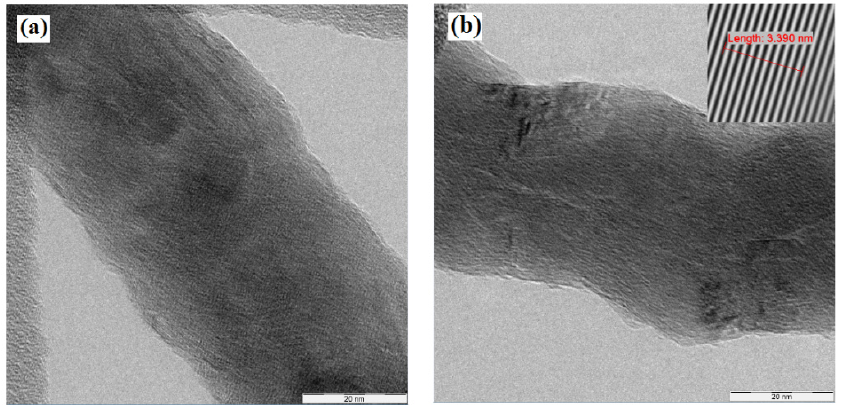
Figure 2. HRTEM micrographs show ( a ) a highly condensed or filled 10 BNNF with no internal space or crack, ( b ) curved 10 BNNF from various points with 10 h-BN species condensed from out to inside. The inset on the upper right-hand corner shows the interlayer spacing.